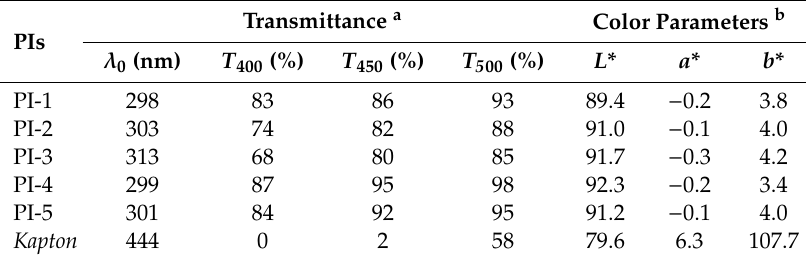
Figure 3. UV–Vis spectra of semi-alicyclic polyimide films and the appearance of PI-1 film. Table 5. Optical properties of semi-alicyclic polyimide films a